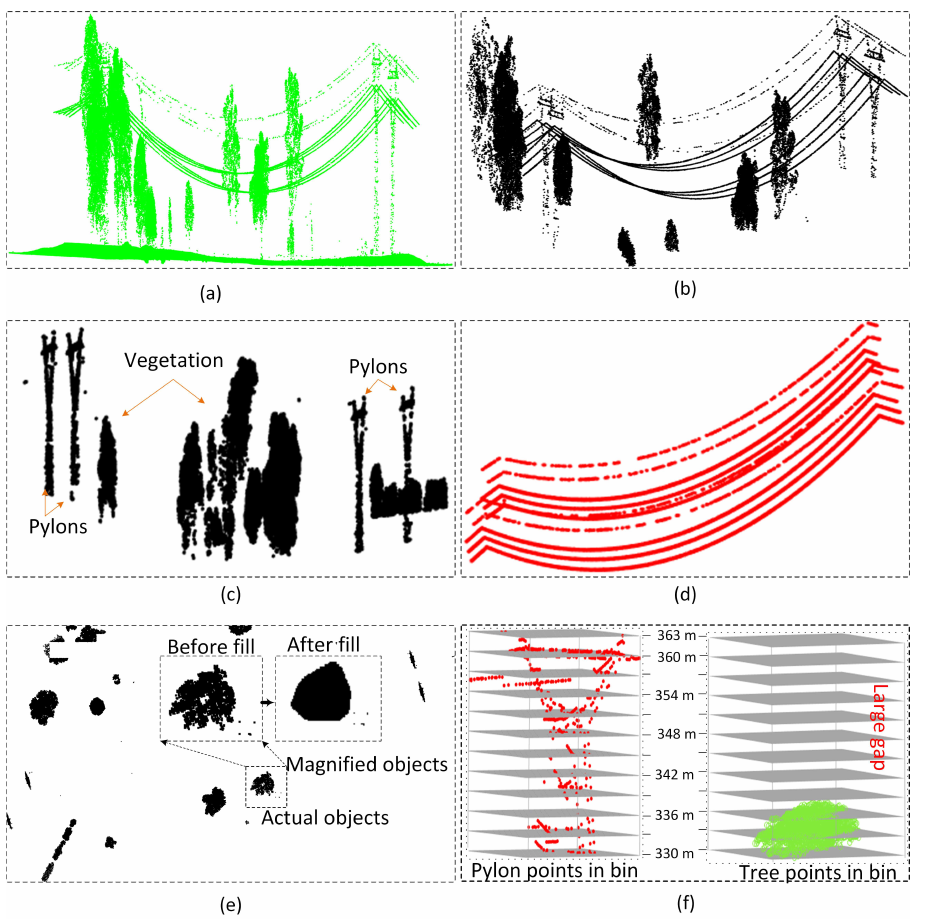
Figure 2. (a) A sample scene, (b) Non-ground points, (c) Vertical object points, (d) Non-vertical object points, (e) Binary mask, and (f) Height bins for points of a pylon and a